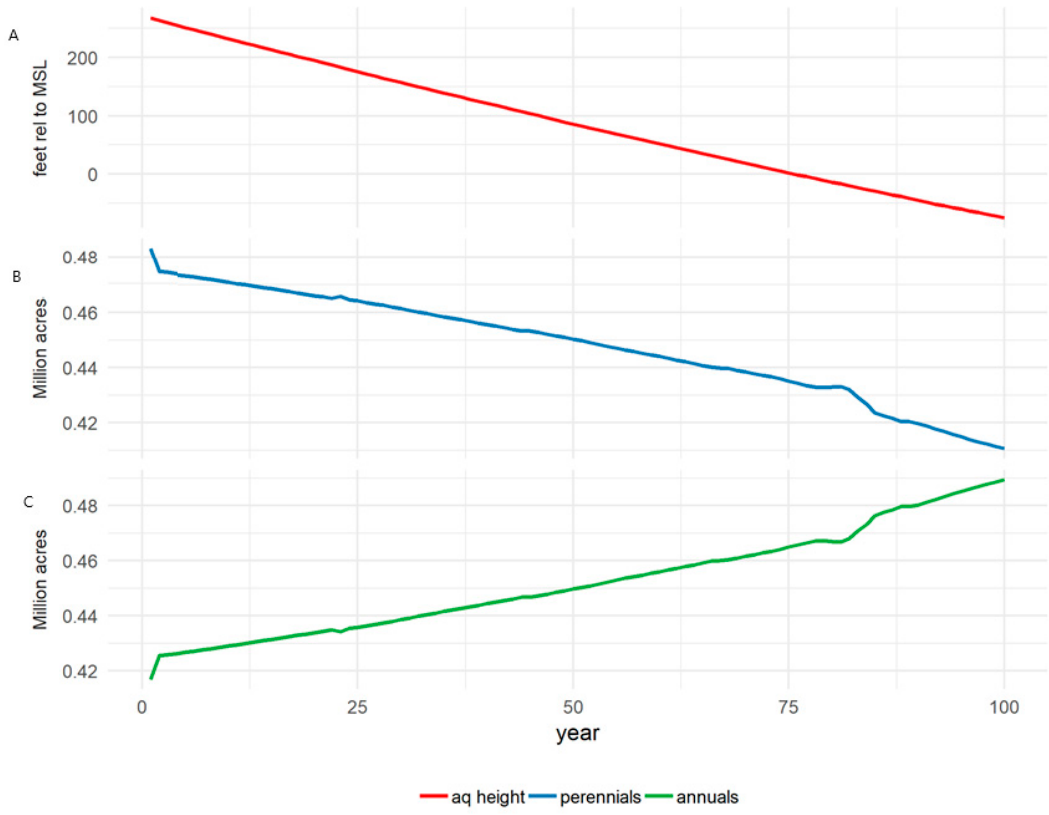
Figure 3. Baseline scenario, where the rows (from top) are the ( A ) aquifer level, ( B ) perennial area, and ( C ) annual